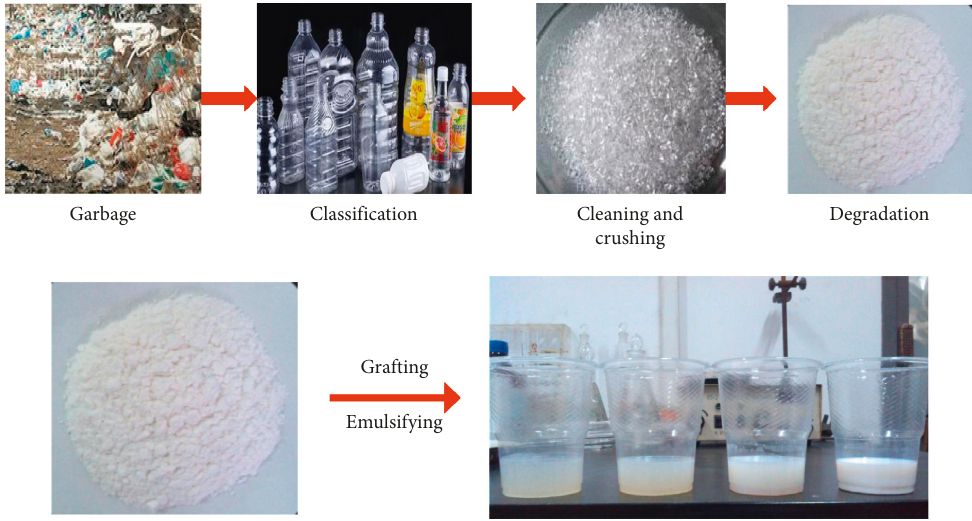
Figure 1: PET degradation process.